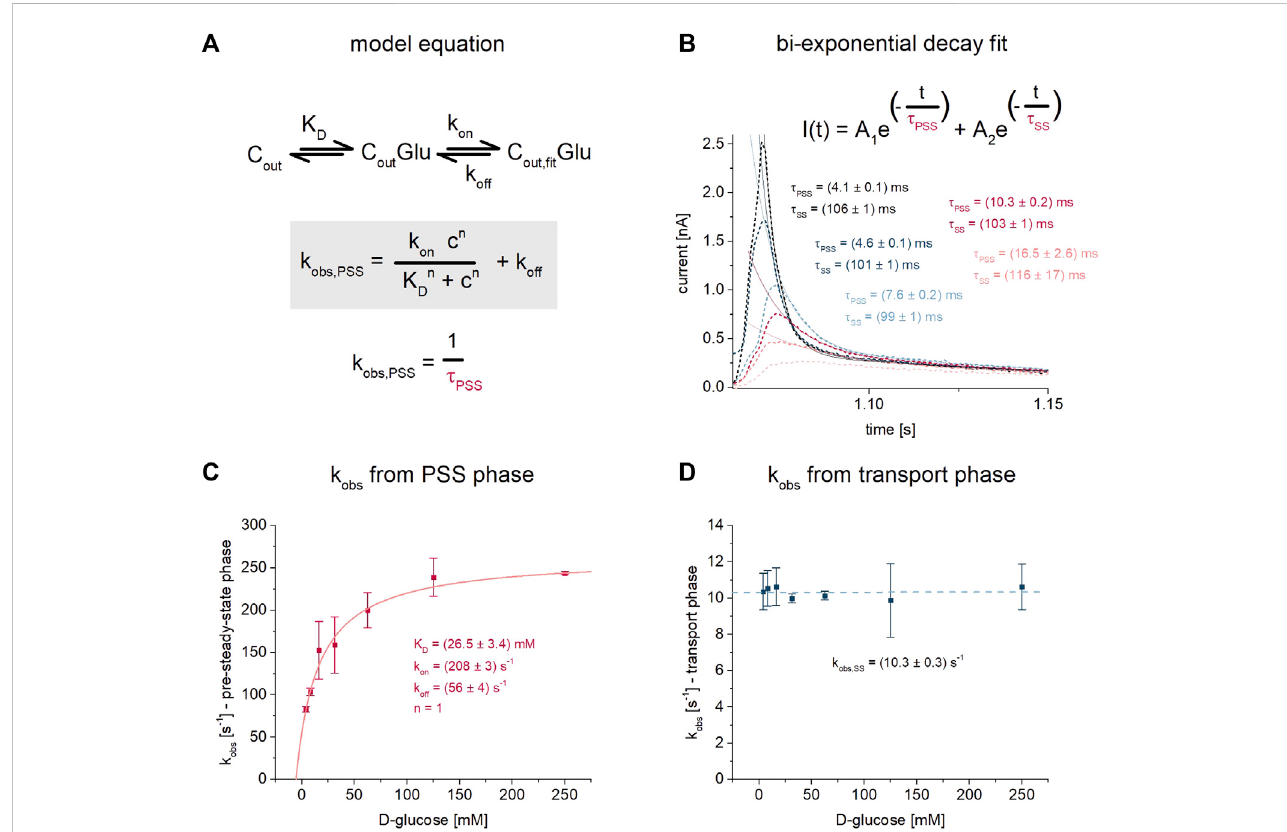
FIGURE 4 D-glucosebindingtoSGLT1inthepresenceofNa + .Forthisanalysisthedatasetrecordedon1 mmsensorsshowninFigure1wasused. (A) Kineticmodel and model equation for D-glucose (Glu) binding to SGLT1 in the outward facing conformation (C out ) followed by an electrogenic conformational transition from C out Glu to C out, fi t Glu – likely representing an induced fi t mechanism. Sugar binding is de fi ned via the K D , while the conformational transition is de fi ned via the rate constants k on and k off . The observed rate constant k obs,PSS = 1/ τ PSS can be written as a function of K D , k on , k off and the sugar concentration c. The time constant τ is the decay time from an exponential fi t of the sugar-induced PSS current. (B) D-glucose concentration dependent traces are taken from Figure 1B. Two decay time constants are derived from bi-exponential fi ts of the current decay: τ τ τ PSS for the fast-decaying PSS current and SS for the slow-decaying transport phase. PSS depends on the sugar concentration according to the model equation. τ SS is a result of the vesicles being charged upon transport, leading to decreasing transport rates over time; it is virtually independent of sugar concentration. (C) Concentration dependent values for k obs,PSS were determined from n = 5 different sensors and averaged, then fi tted using the model equation shown in (A). For the fi t, the Hill coef fi cient n was fi xed to 1 representing one sugar molecule binding to SGLT1, while values for K D = 26.5 ± 3.4 mM, k on = 208 ± 3 s − 1 and k off = 56 ± 4 s − 1 were determined. The great fi t ( R 2 > 0.999) validates the use of the model equation for our data. The K D is slightly higher compared to the K D app values obtained from the analysis procedures given in Figure 1. (D) Values for k obs,SS were averaged from the same n = 5 sensors as used for the k obs,PSS analysis shown in (C). Averaged values were plotted to show that the decay of the transport phase is independent of sugar concentration. k obs of 10.3 ± 0.3 s − 1 represents the average for all sugar